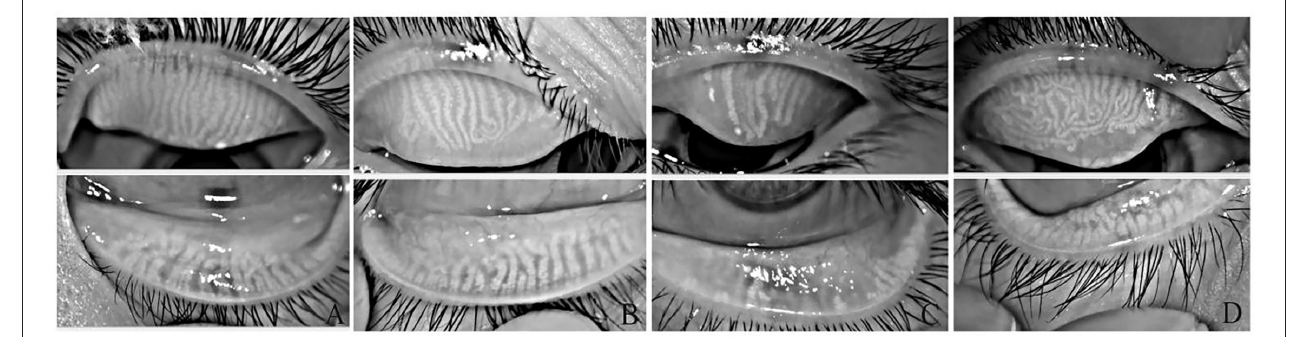
FIGURE 1 | Different meibomian gland morphologies in ametropic children. (A) 0–25% area of loss. (B) 25–50% area of loss. (C) 50–75% area of loss. (D) Meibomian glands were twisted, and some meibomian glands were twisted more than 90 ◦ .